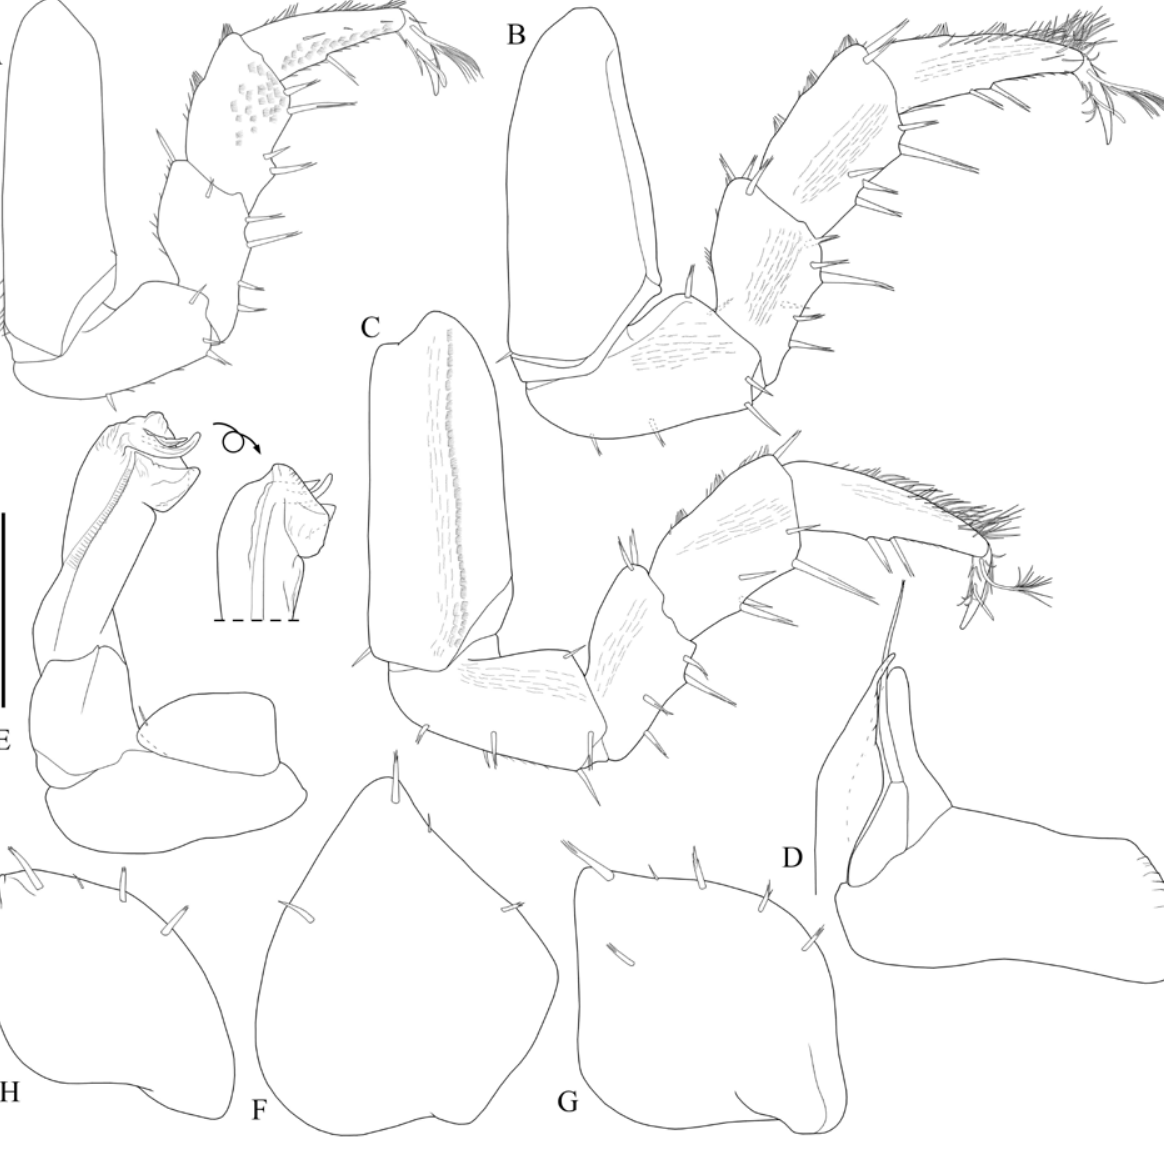
Figure 9. Pectenoniscus iuiuensis n. sp. Male paratype: A , pereopod 1; B , pereopod 6; C , pereopod 7; D , genital papilla and pleopod 1; E , pleopod 2; F , pleopod 3 exopod; G , pleopod 4 exopod; H , pleopod 5 exopod. Scale bars: 0.2